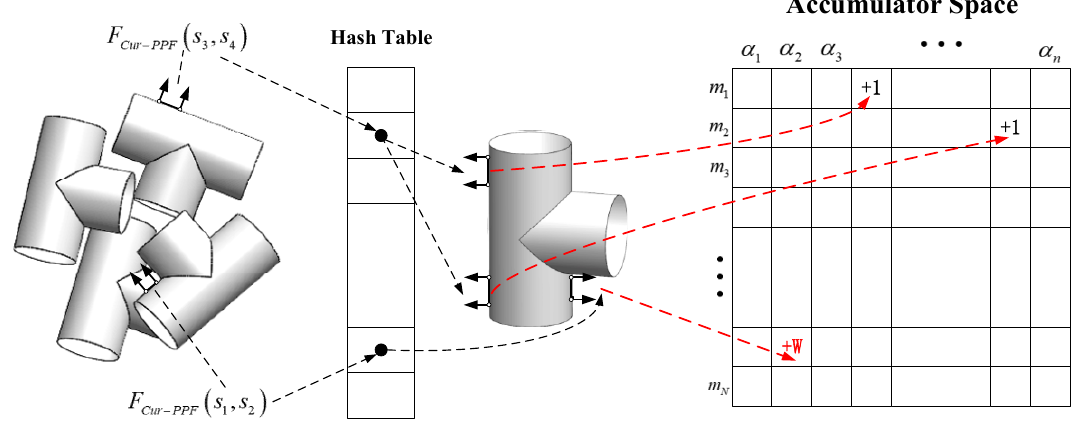
Figure 8. Because the scene point-pair ( s 3 , s 4 ) is matched with two points of the same curvature class in the model point-pair, the number of pose votes is one by default; when matching ( s 1 , s 2 ) , the two points in the model point-pair are in the set high-curvature and low-curvature ranges respectively, so the match contains more information and weighted voting is performed on the pose.